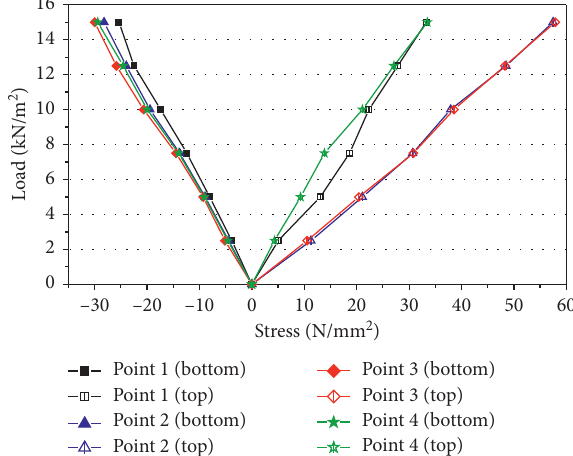
Figure 8: Load-stress curves of the single-span simply supported formwork